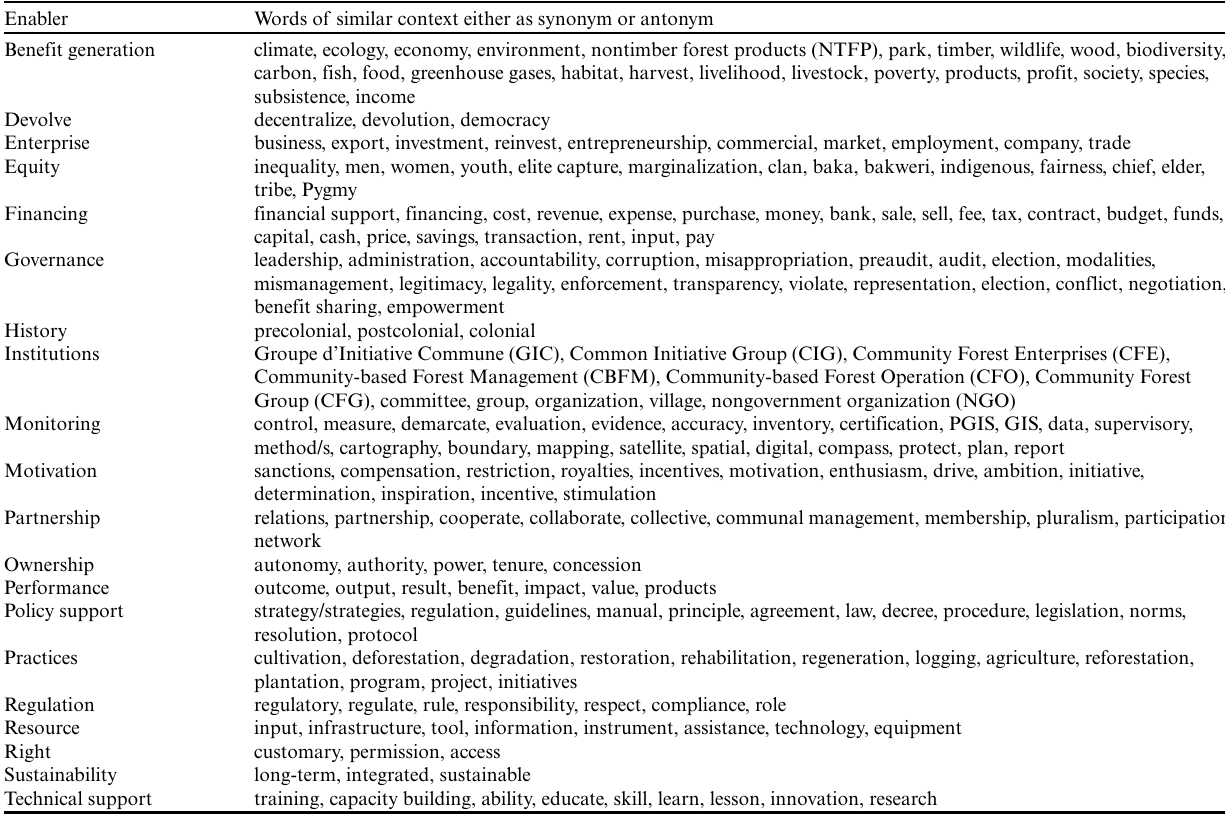
Table 1 . The 20 enablers and the relevant synonyms and antonyms used.